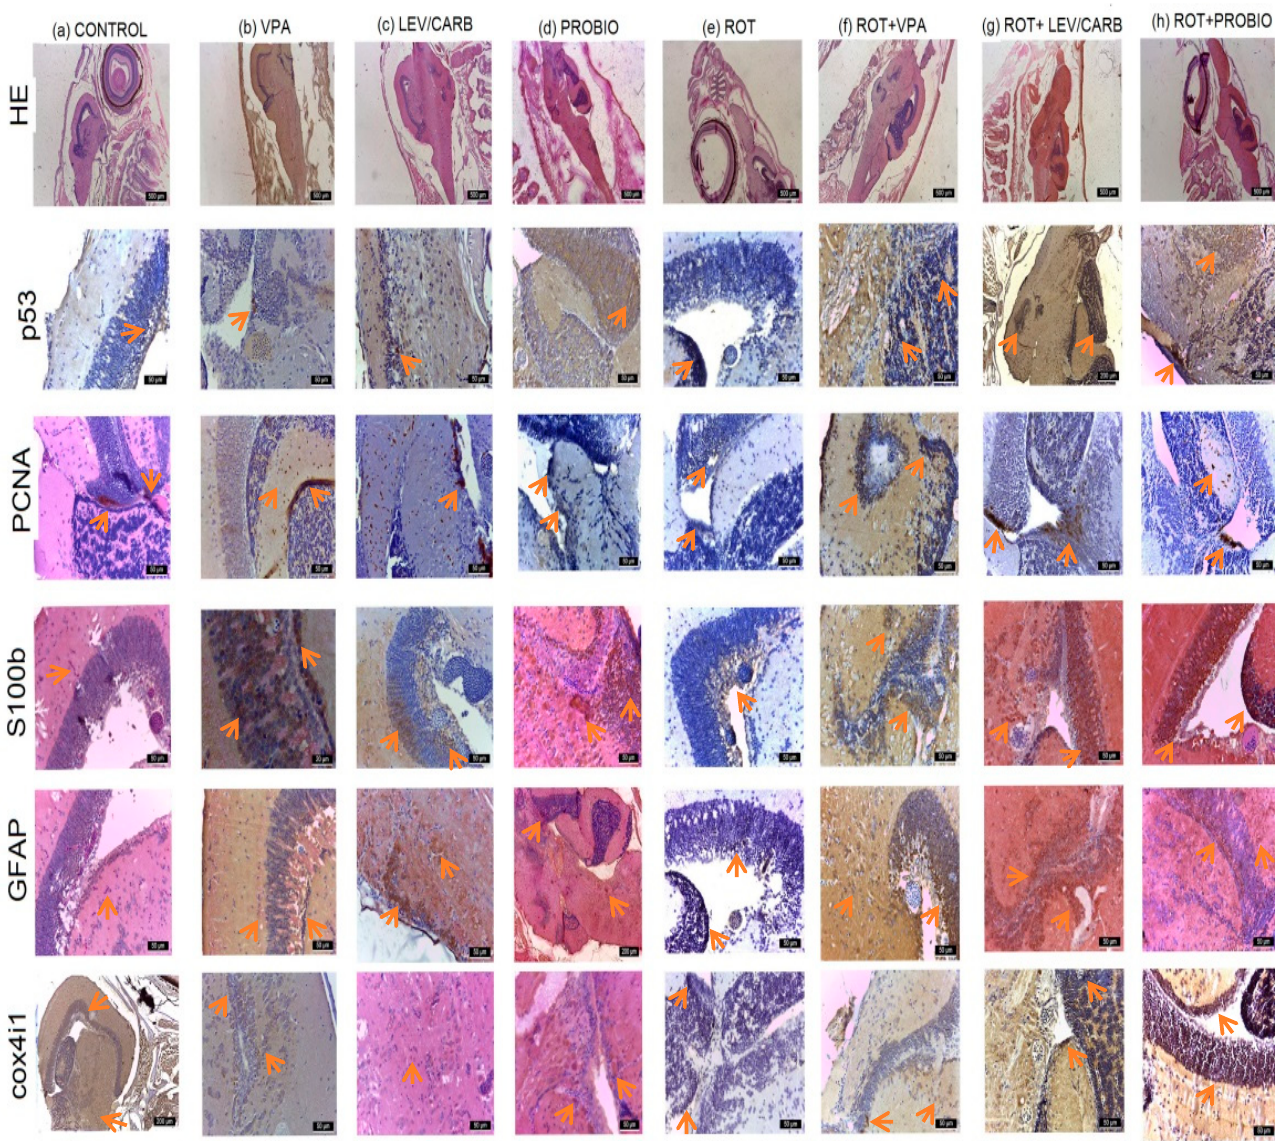
Figure 5. The reactivity of the nervous system in studied Danio rerio ( n = 5) groups of HE, p53, PCNA, S100b, GFAP, and cox4i1.